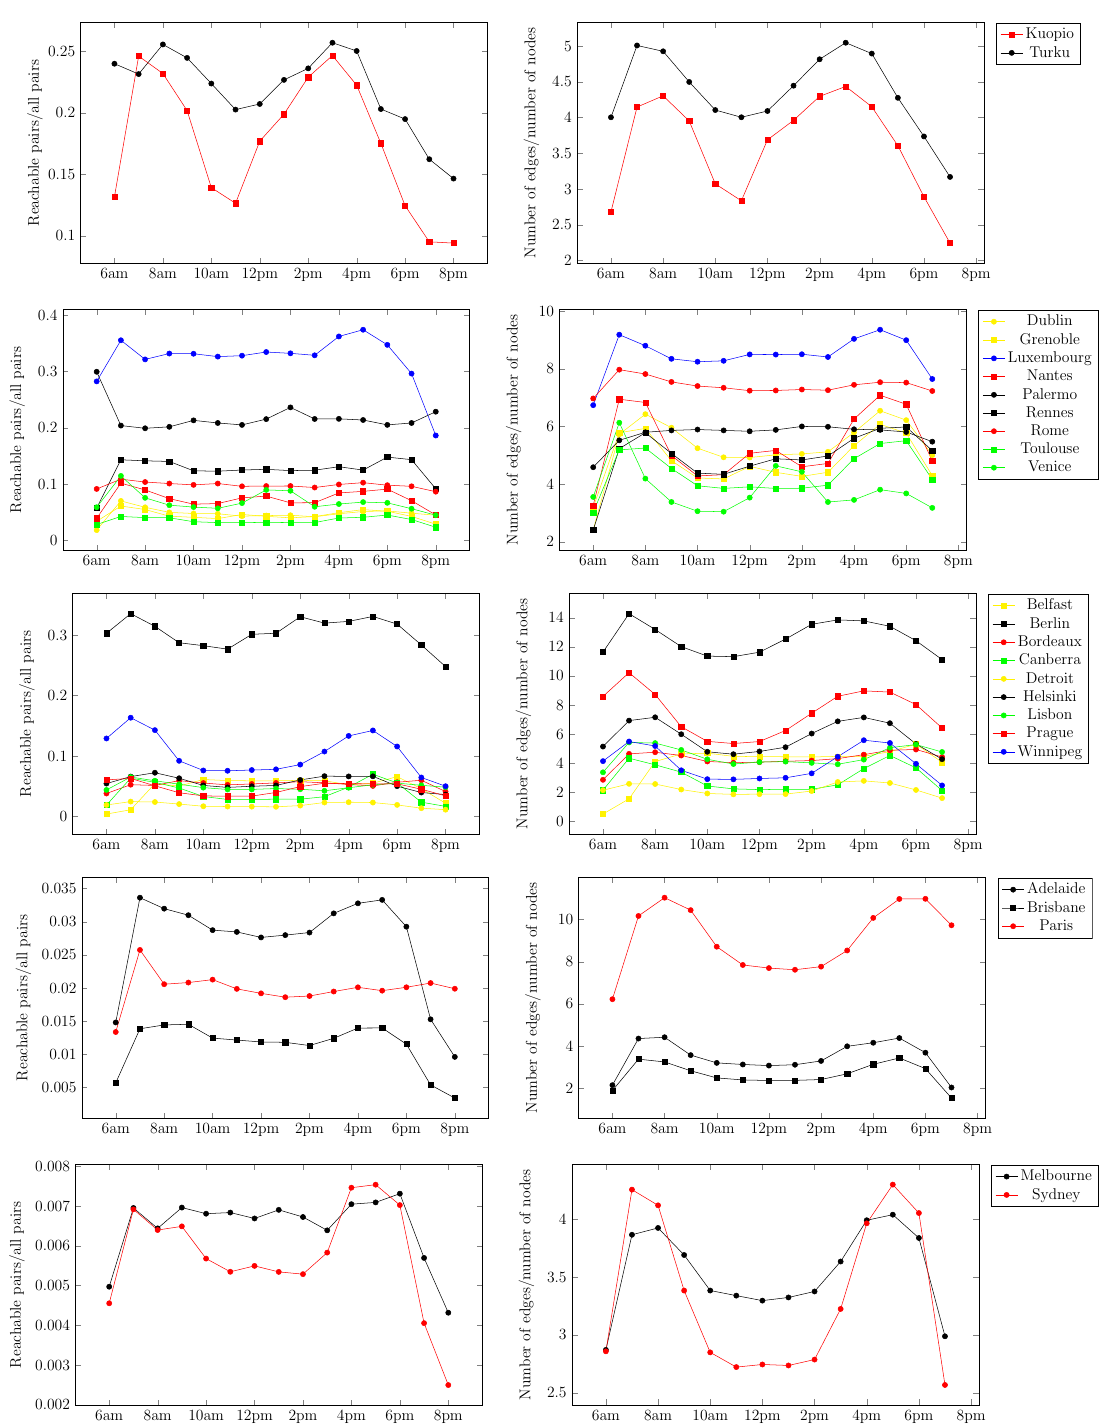
Figure 6. The comparison of the reachability diagrams ( left ) and of the density diagrams ( right ) of the 25 public transport